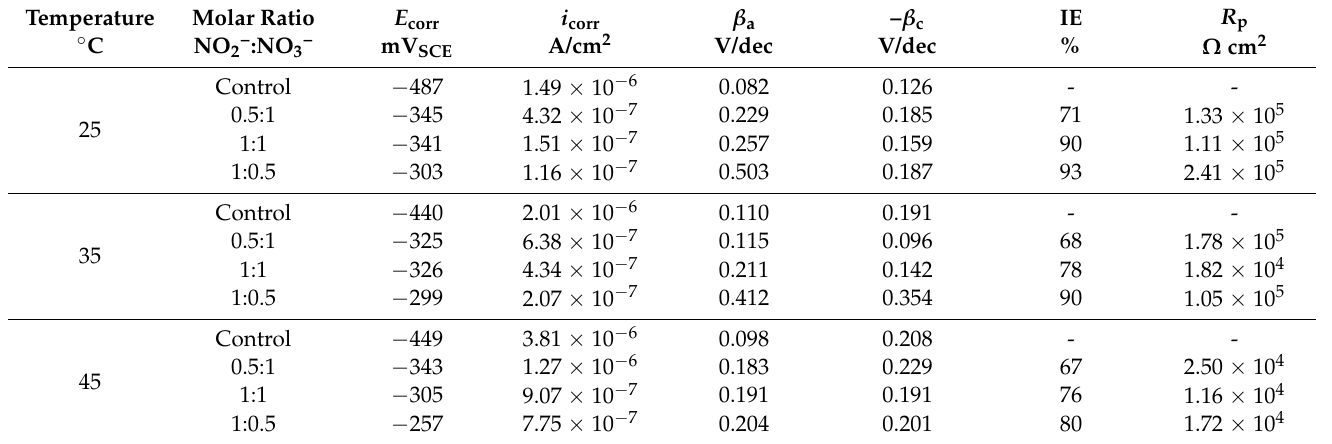
Figure 3. CPP plots of NaNO 2 and NaNO 3 obtained in SCPS contaminated with 0.6 M NaCl under constant temperature of ( a ) 25 ◦ C, ( b ) 35 ◦ C, and ( c ) 45 ◦ C. Table 3. Corrosion kinetic parameters obtained from steel rebars immersed in SCPS with 0.6 M NaCl with and without corrosion inhibitors in molar ratios of 0.5:1, 1:1, and 1:0.5 for NaNO 2 :NaNO 3 at 25, 35, and 45 °C.